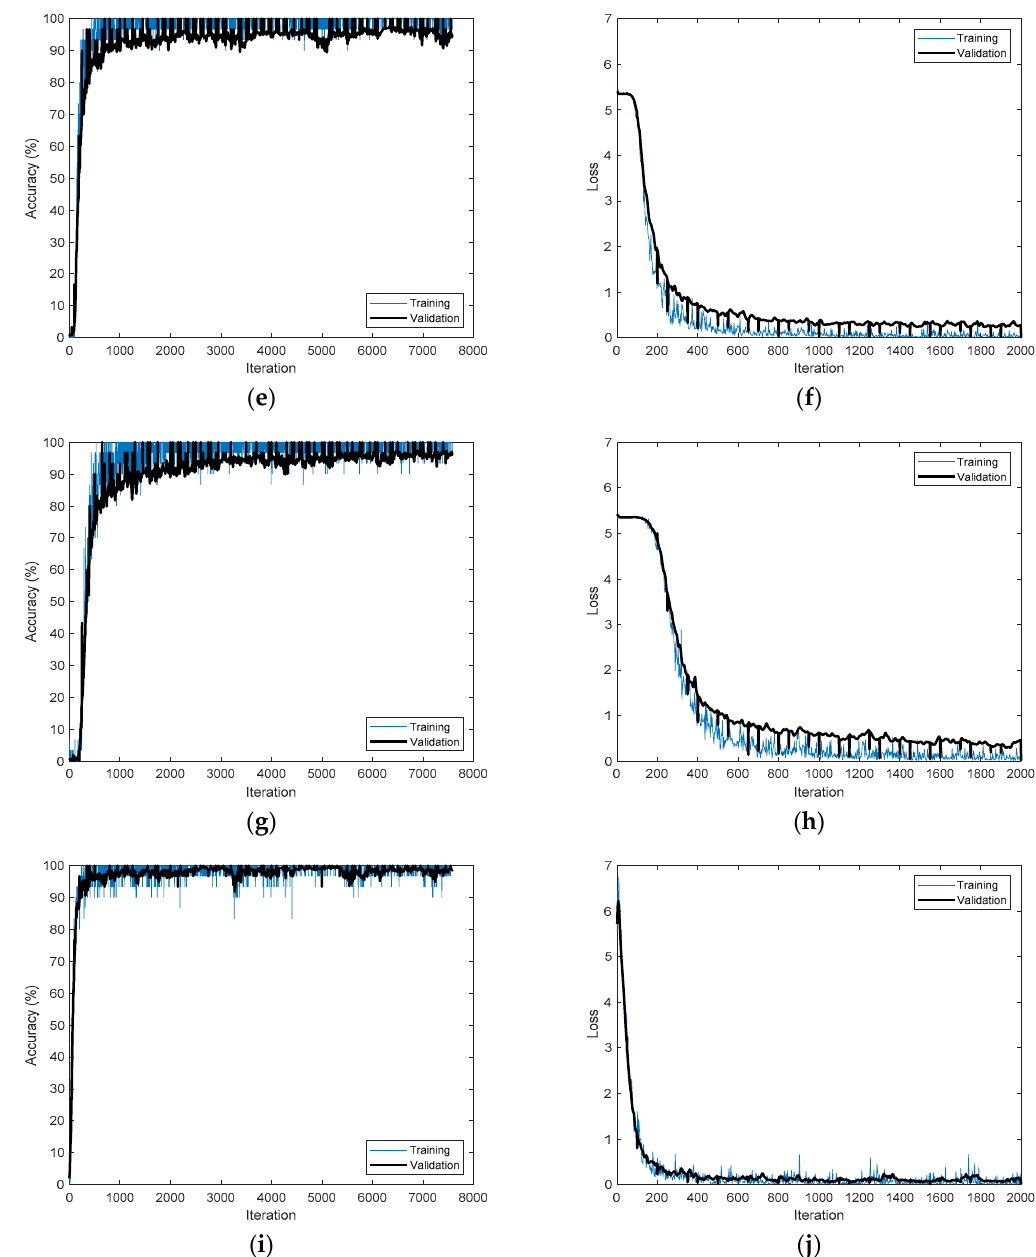
Figure 12. Training processes that achieved the best accuracies for the time-frequency representations applied to PTB-ECG. ( a ) Accuracy of DenseNet-201 using MFCC; ( b ) loss of DenseNet-201 using MFCC; ( c ) accuracy of Xception using spectrogram; ( d ) loss of Xception using spectrogram; ( e ) accuracy of Xception using log spectrogram; ( f ) loss of Xception using log spectrogram; ( g ) accuracy of Xception using mel spectrogram; ( h ) loss of Xception using mel spectrogram; ( i ) accuracy of ResNet-101 using scalogram; ( j ) loss of ResNet-101 using scalogram.